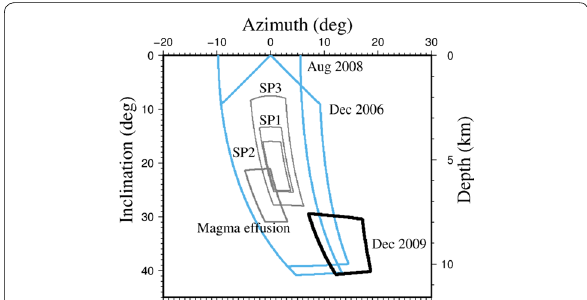
Fig. 5 Ranges of azimuths and inclination angles from ISA to possible source locations. Azimuths are measured anticlockwise from E1. A range of source locations that provides consistent values of E1, E2, and E3 is indicated for each event. The thick black line shows the strain change in Dec 2009. Thin gray contours show strain changes estimated during the climactic event of Jan 2011, comprising three sub-Plinian eruptions (SP1–3) and subsequent magma effusion (Yamazaki et al. 2013). Blue contours show strain changes in Dec 2006 and Aug 2008, details of which are shown in Fig. 7. The depths equivalent to the inclination angle at an assumed epicenter distance of 11.6 km (Yamazaki et al. 2013) are shown on the right axis for